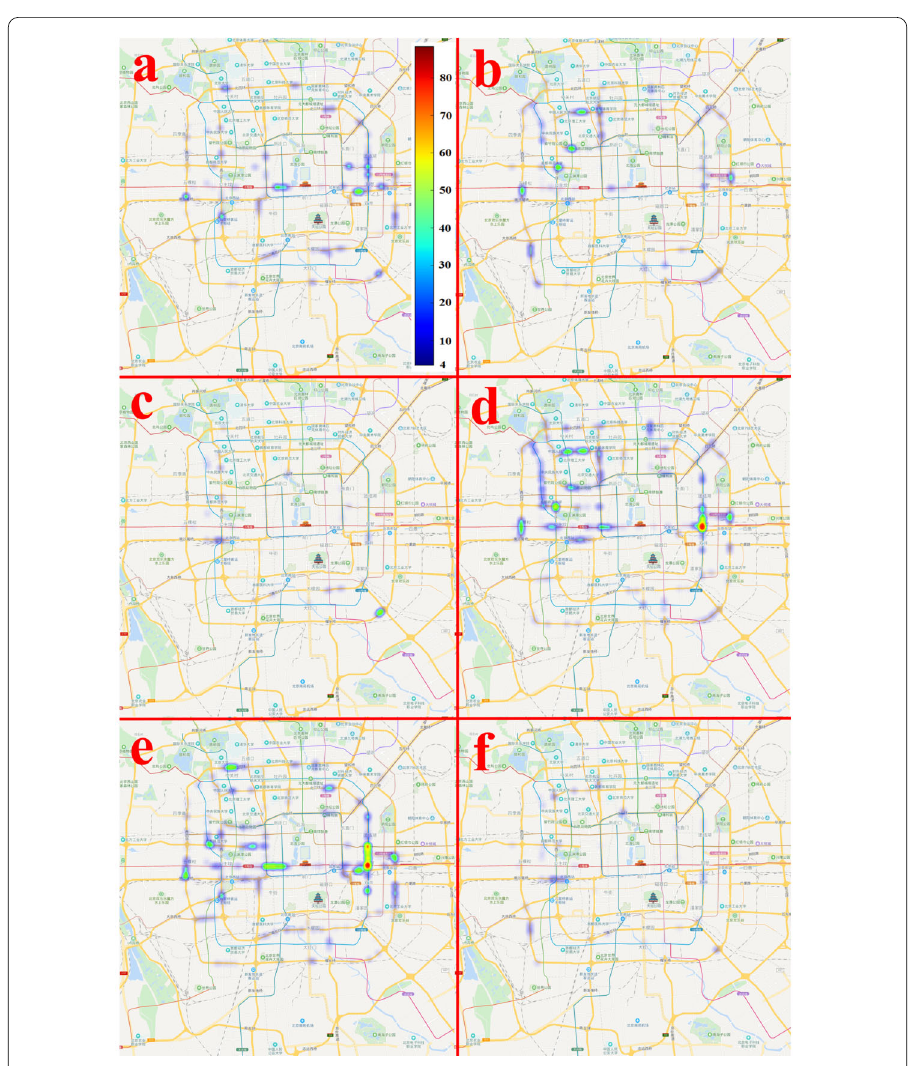
Figure 7 Heat maps of major differences between weighted degrees in different time periods. ( a ) 465 nodes in RH1 with more than 4 times larger weighted degrees than NT1. The color of each node shows its weighted degree in RH1. ( b ) 486 nodes in NT1 with more than 4 times larger weighted degrees than RH1. The color of each node shows its weighted degree in NT1. ( c ) 182 nodes in RH2 with more than 4 times larger weighted degrees than NT1. ( d ) 752 nodes in NT1 with more than 4 times larger weighted degrees than RH2. ( e ) 764 nodes in RH1 with more than 4 times larger weighted degrees than RH2. ( f ) 210 nodes in RH2 with more than 4 times larger weighted degrees than RH1. The data is during 26–30 Oct. 2015, N = 4530, L = 900, and τ max =